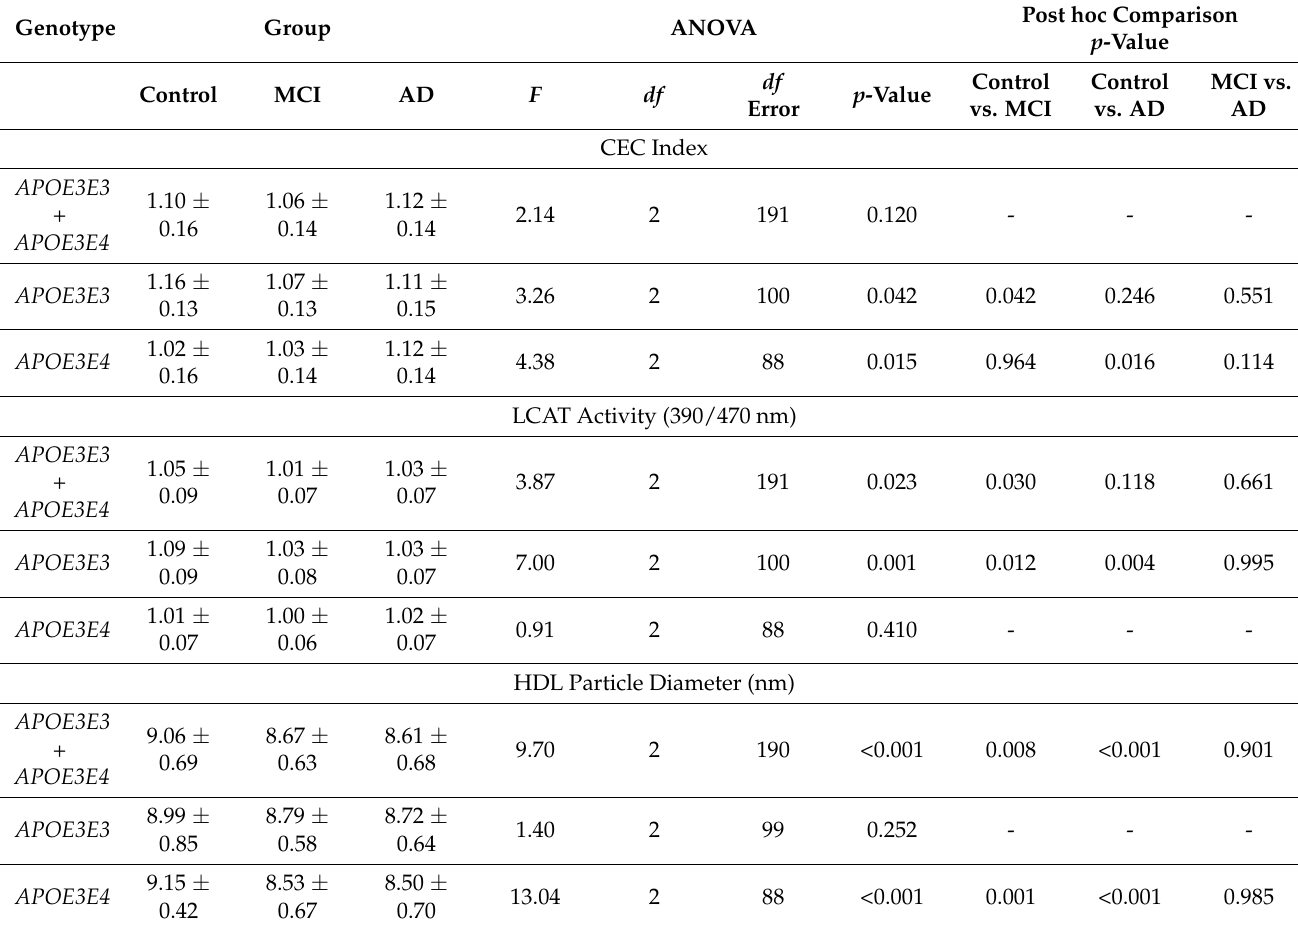
Table 2. Comparison of the HDL CEC index, LCAT activity, and particle size across